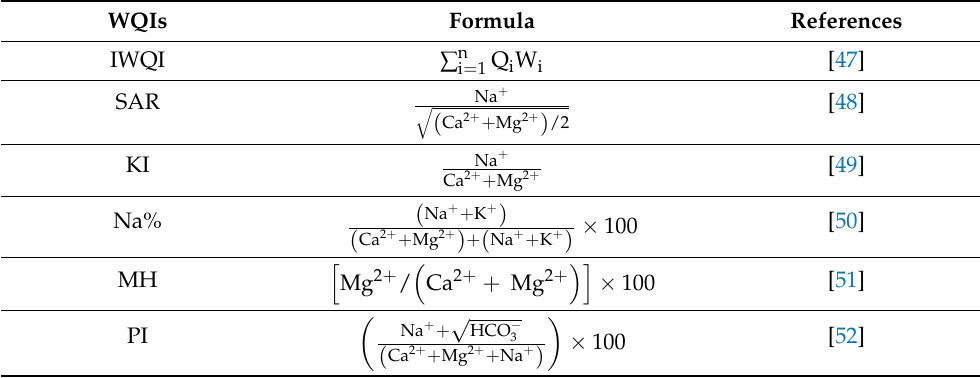
Table 1. The IWQIs, related formula and